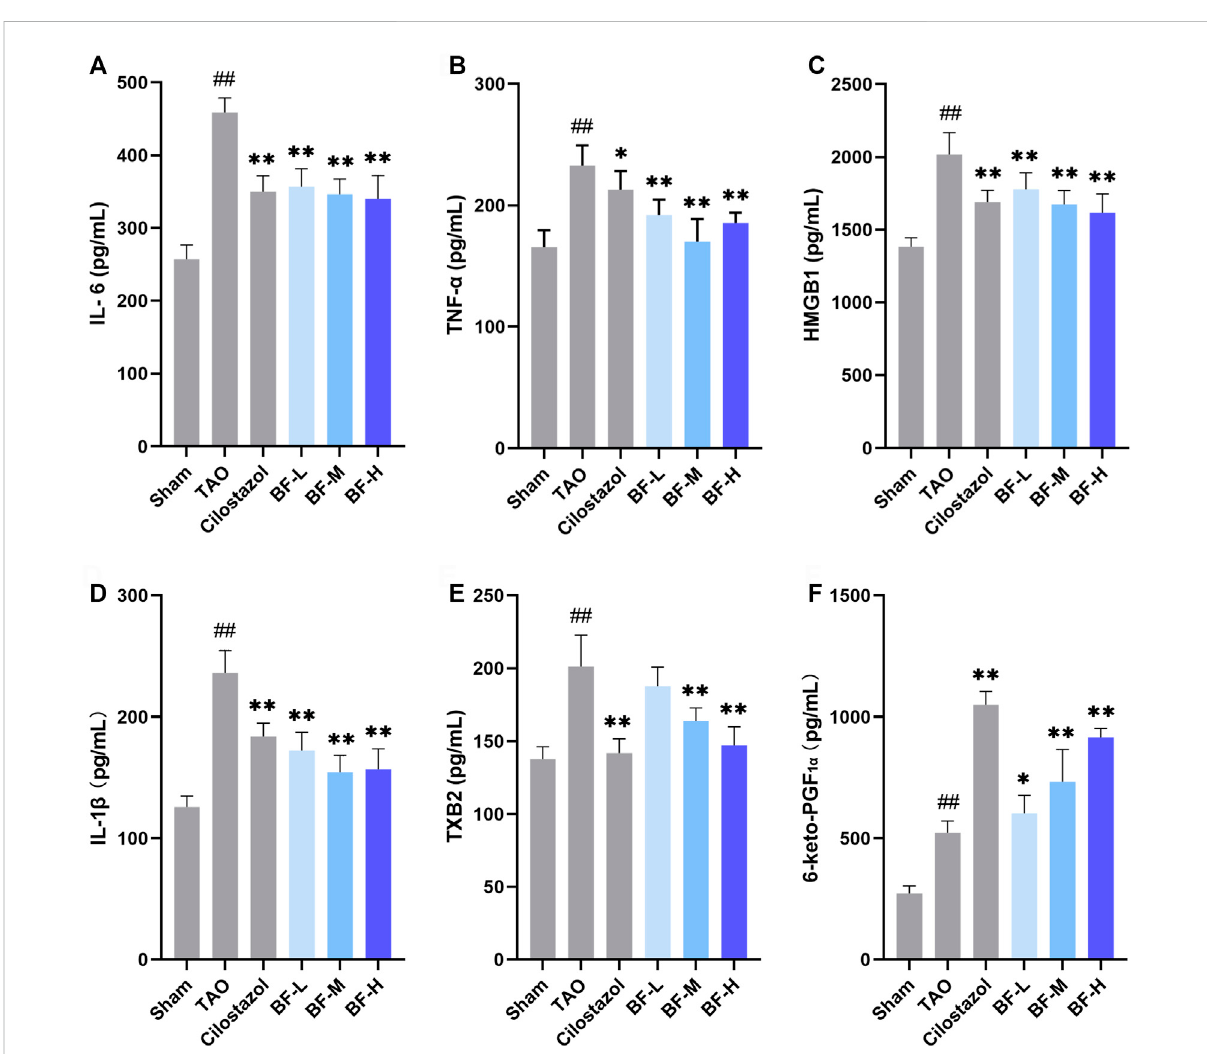
FIGURE 5 Effects of Baiying Qingmai Formulation (BF) on (A) IL-6, (B) TNF- α , (C) HMGB1, (D) IL-1 β , (E) TXB2, (F) 6-keto-PGF1 α levels in the plasma of rats with TAO. Data are presented as mean ± SEM ( n = 6). # p < 0.05, ## p < 0.01 versus Sham, * p < 0.05, ** p < 0.01 versus TAO. Sham: sham-operated group; TAO: TAO model group; Cilostazol: cilostazol group; BF-L: BF low-dose group; BF-M: BF medium-dose group; BF-H: BF high-dose